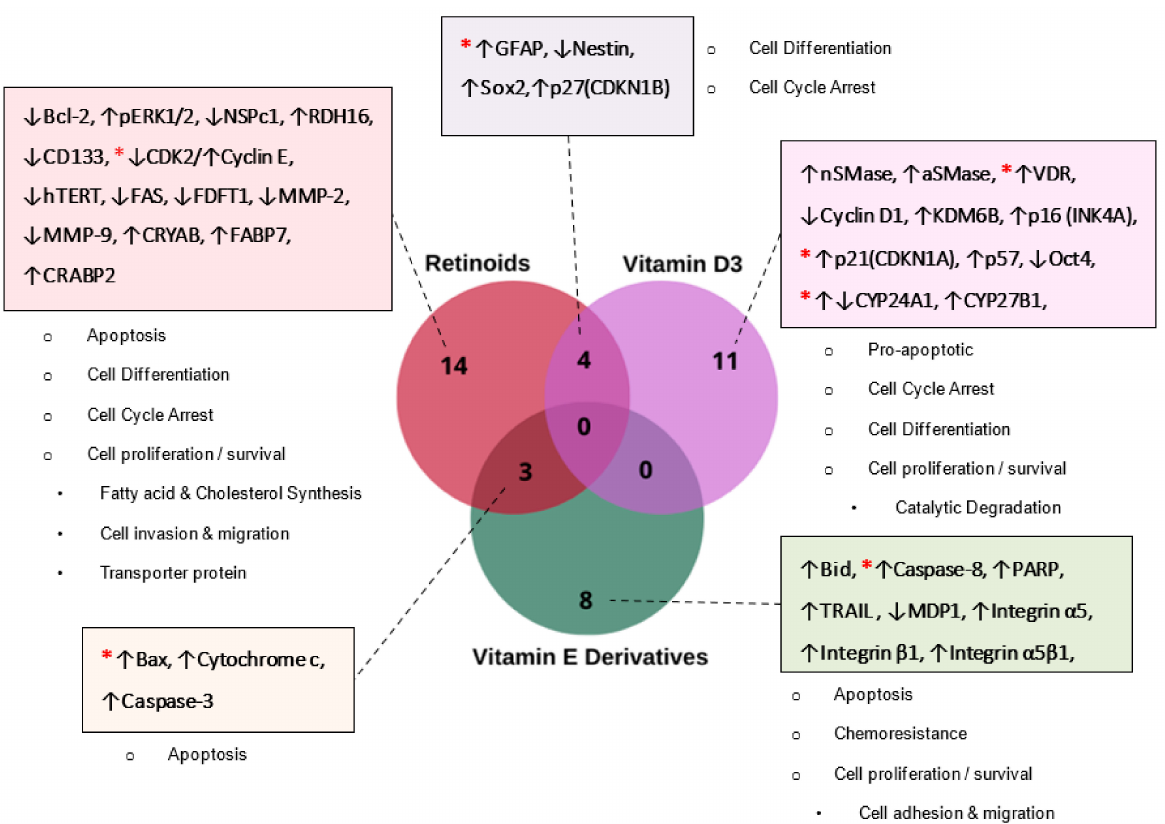
Figure 4. Venn diagram showing biomarkers regulated by the lipid-soluble vitamins A ‘Retinoids’ (red circle), D3 (purple circle), and E derivatives (green circle), with the corresponding molecular mechanism identified from the 19 eligible studies shortlisted in Table 1. * Represents a replicable biomarker within the same vitamin